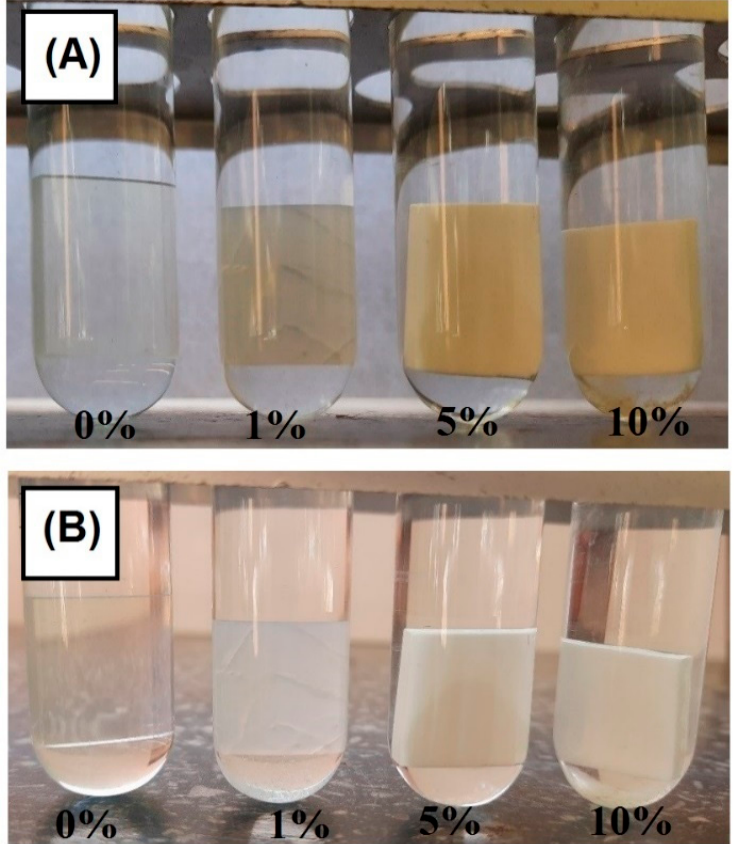
Figure 13. Swelling test for EGDMA + MMA-based materials in acetone ( A ) and BPA.GDA + MMA-based materials in HCl ( B ).